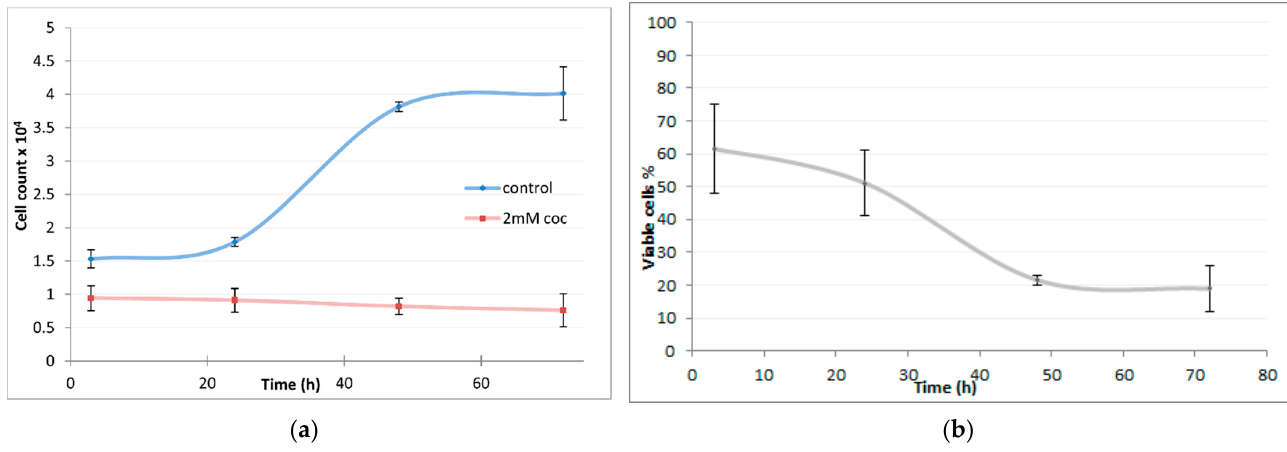
Figure 2. ( a ) Number of cells count vs. time upon treatment with 2 mM of cocaine; blue line corresponds to control cell culture; red line corresponds to treated culture with 2 mM of cocaine. ( b ) Percentage of viable cells treated with 2 mM of cocaine over time. The values are presented as means ± SD shown with error bars.